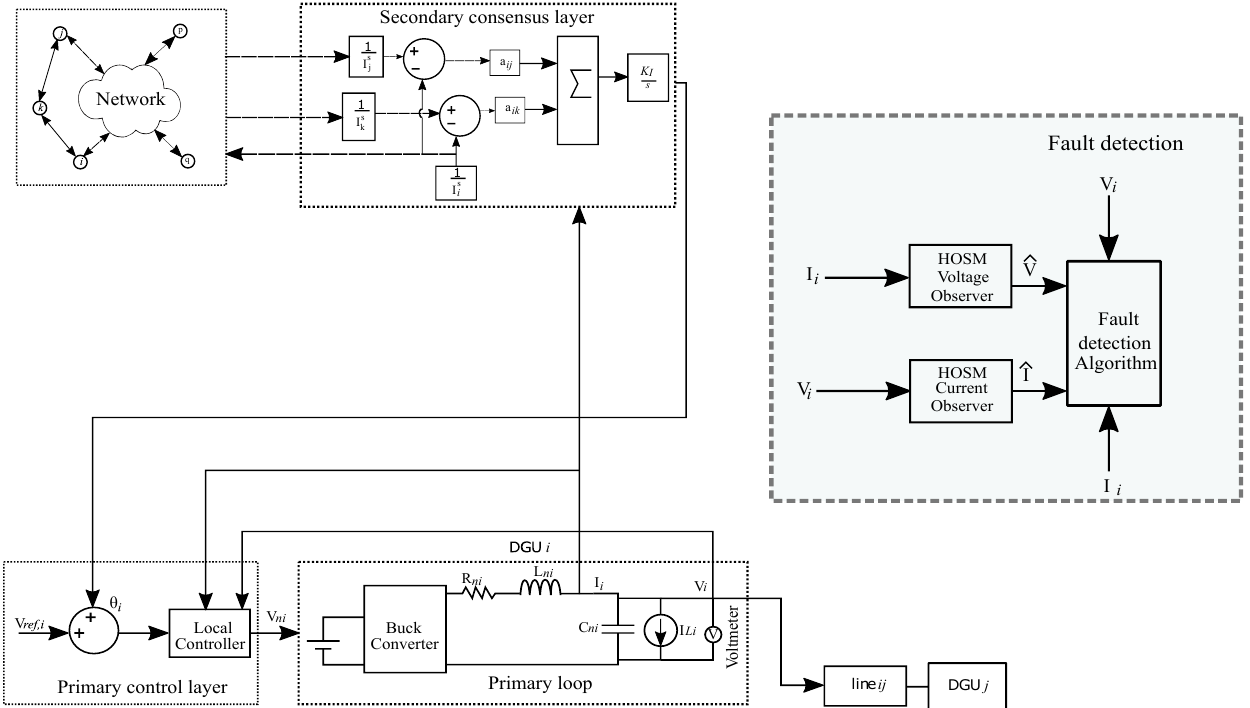
Figure 3. Functional block diagram of i th DGU with controllers and higher order sliding mode (HOSM) observers.